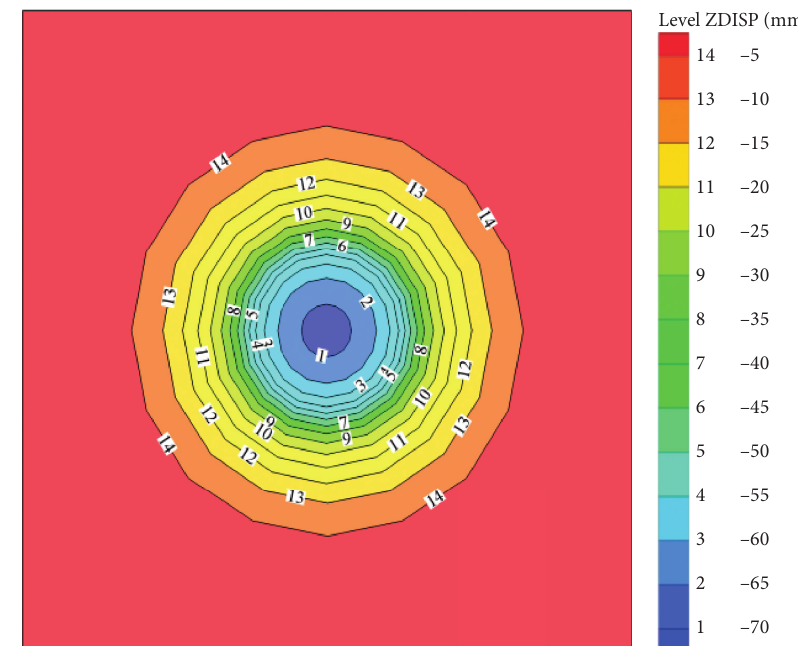
Figure 9: Contour of z -directional (vertical) displacement (top